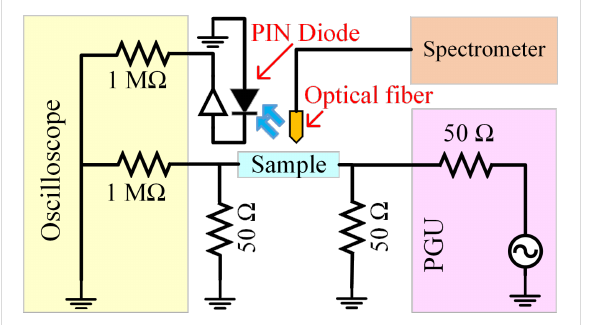
Figure 2: The schematics of a typical measurement setup with a pulse generating unit (PGU). An optical spectrometer was used to perform spectral analysis with time resolution of ≥ 1 ms in the 200–1100 nm range.